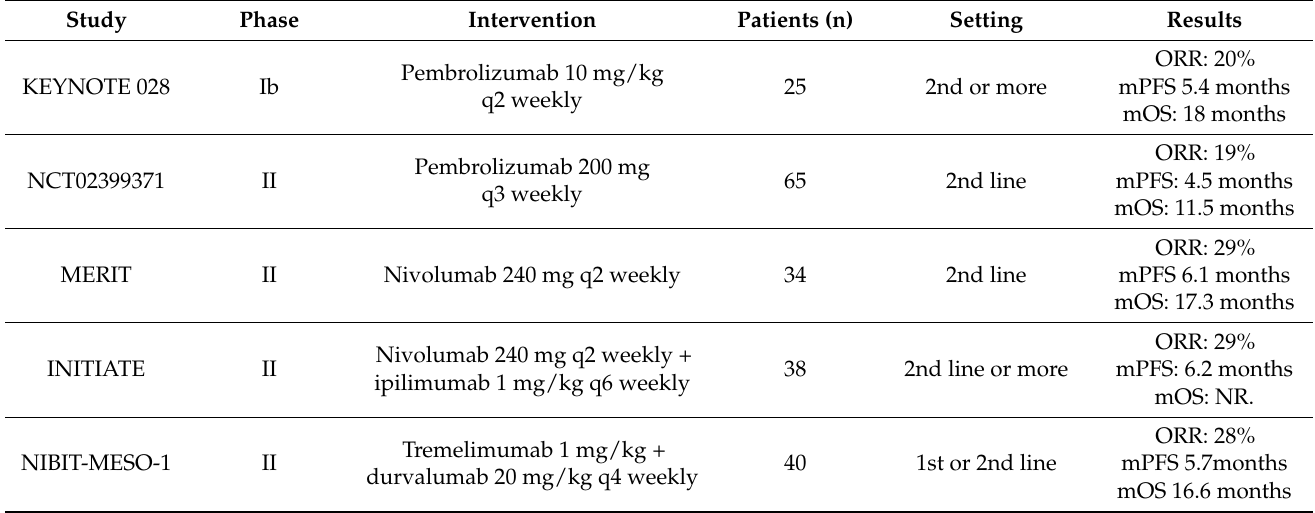
Table 1. Selected single arm trials of immune-checkpoint inhibitors in MPM.